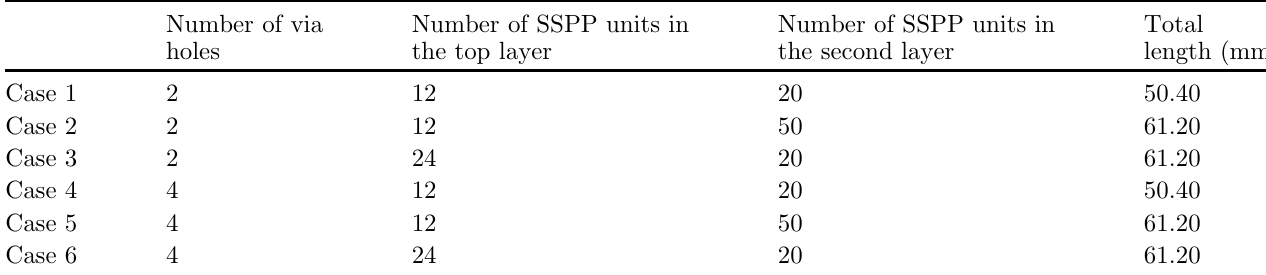
Table. 1. Cases of Multi-Layer SSPP TLs.